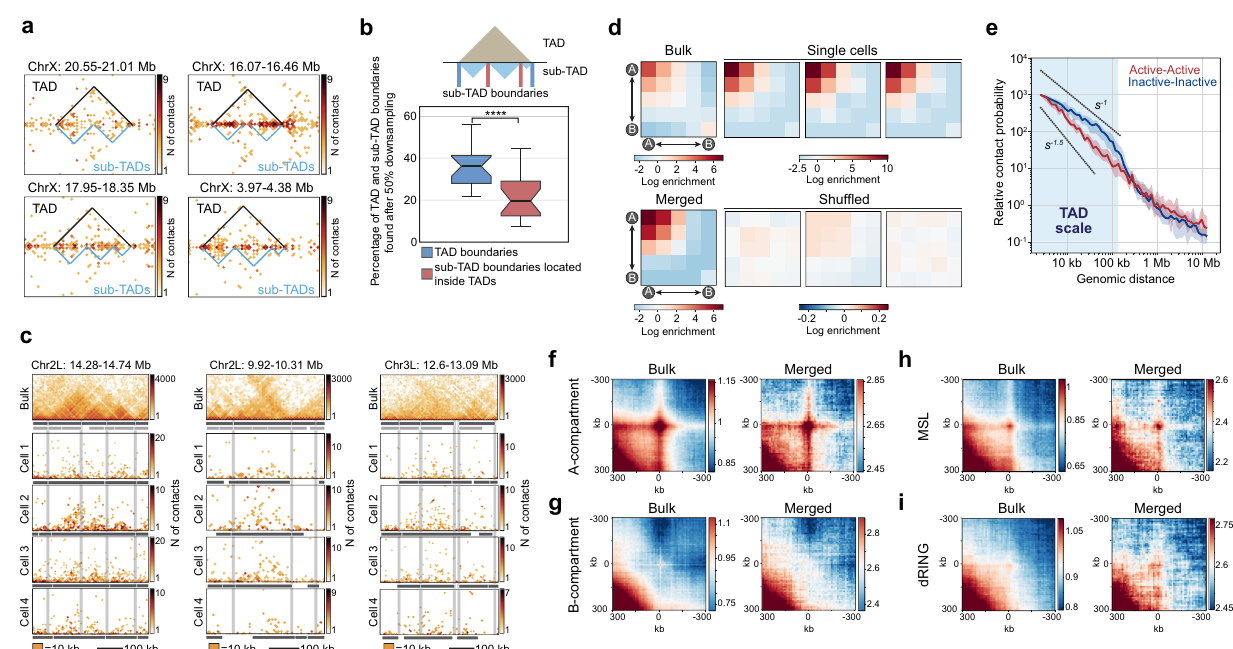
Fig. 4 Chromatin in individual Drosophila cells is compartmentalized and lacks folding hierarchy at the level of TADs. a Examples of TAD (black triangles) and sub-TAD (light blue triangles) positions in the haploid X chromosome in individual nuclei with 77,770 unique contacts. b Percentage of TAD and sub-TAD boundaries per cell (excluding TAD boundaries for the same cells) found as sub-TAD boundaries in the snHi-C maps after 50% downsampling. Downsampling was performed 10 times. At the top: TAD boundaries are highlighted with blue lines, sub-TAD boundaries located inside TADs are highlighted with red lines. Boxplots represent the median, interquartile range, maximum and minimum. **** p -value < 0.0001 using the Mann – Whitney two-sided test. n = 20 cells. c Genomic regions with alternative chromatin folding patterns in individual cells. Positions of sub-TADs and TADs identi fi ed in bulk BG3 in situ Hi-C data (top panels) are highlighted with light gray and dark gray rectangles, respectively. Positions of TAD boundaries in bulk BG3 in situ Hi-C data are shown with vertical light gray lines. d Heatmaps showing log 2 values of contact enrichment between genomic regions belonging to putative A- (negative PC1 values) and B- (positive PC1 values) compartments (saddle plot). PC1 pro fi le is constructed using the bulk BG3 in situ Hi-C data. e Contact probability P c ( s ) between transcriptionally active (red) and inactive (blue) genomic bins in the snHi-C data. The light blue shading shows the genomic distances corresponding to the average TAD size in single nuclei. f Average plot of long-range interactions between top 1000 regions of A compartment annotated by bulk Hi-C data (in bulk Hi-C and merged snHi-C). g Average plot of long-range interactions between top 1000 regions of B compartment annotated by bulk Hi-C data (in bulk Hi-C and merged snHi-C). h Average plot of interactions between top 500 regions enriched in MSL (in bulk Hi-C and merged snHi-C) on chromosome X. i Average plot of interactions between top 500 regions enriched in dRING (in bulk Hi-C and merged